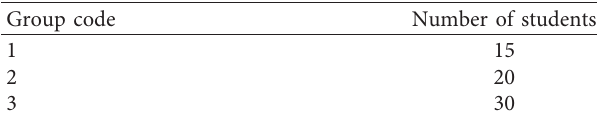
Table 6: The number of students in each